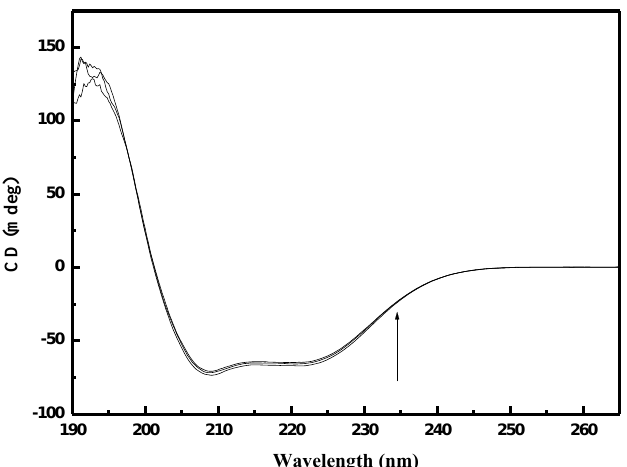
Figure 10. CD spectra of bovine serum albumin (BSA) in the presence of prothioconazole (PTC). The α -helix contents of free BSA, and HSA and pesticides/BSA; pesticide/HSA com- plexes were calculated from MRE values at 208 nm using the following Equation (7)